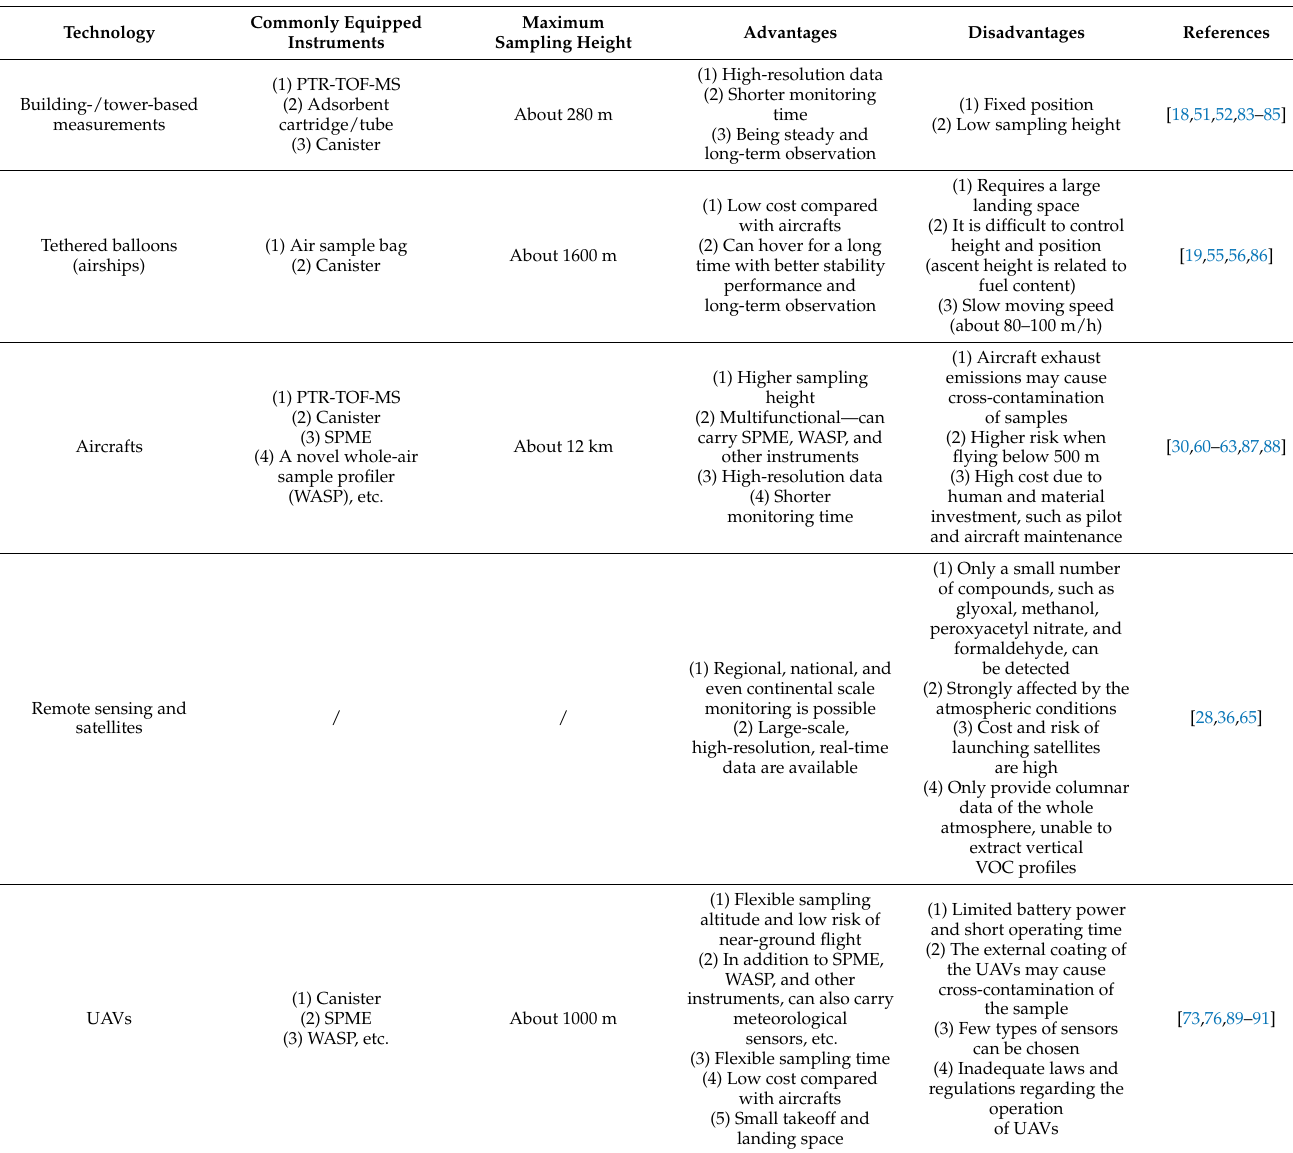
Table 3. VOC vertical distribution sampling